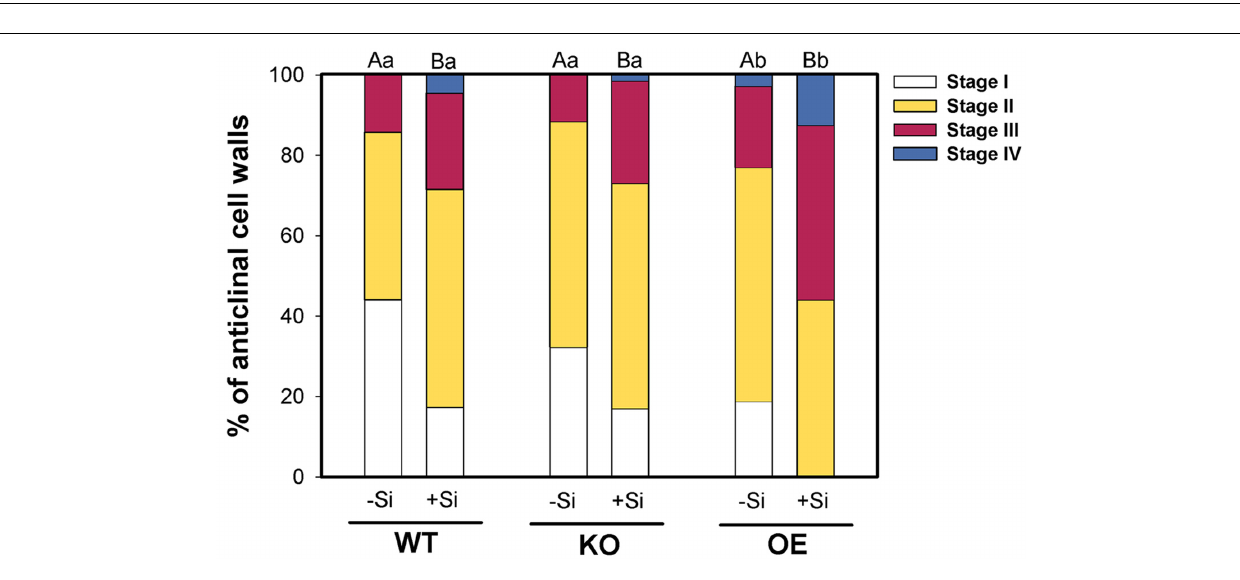
FIGURE 3 | Development of CB in the exodermis of WT plants and the mutant lines 1B-14436 (KO) and 3A-16329 (OE) as affected by Si supply (concentration are given in the legend of Figure 1). The root zone investigated was 4–6 cm behind the root tip. The CB formation was classified in four